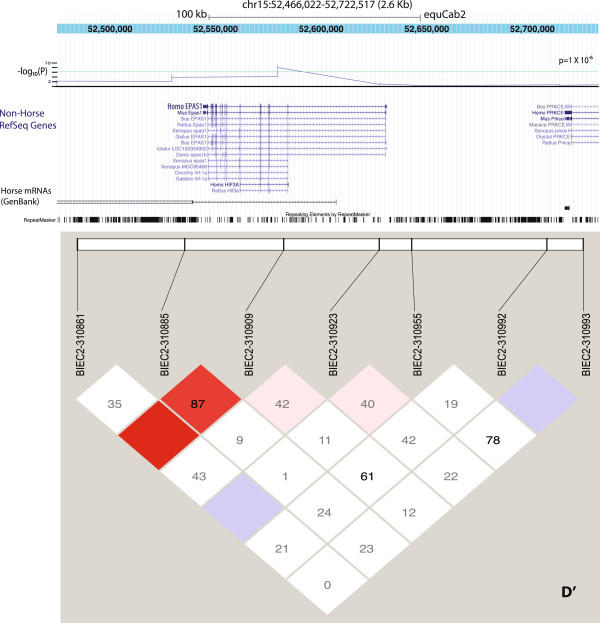
The placement of significant SNPs within the EPAS1 gene. The –log(p-value) for individual SNPs in the region is indicted above the assembly of EPAS1 genes. The green line represents genome wide significance. D’ values are shown. The SNP shown, BIEC2–310909 (rs69041973) was highly significant (p = 9.27 × 10-8). This SNP is an intronic SNP with no known function.